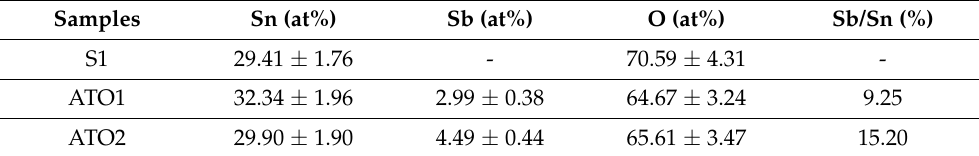
Figure 3. X-ray diffraction patterns ( a ) and crystallinity size ( b – d ) of S1, ATO1, and ATO2 estimated by the Rietveld and Le Bail approach from XRD data analysis, in the three directions of (111), (100), and (001). Table 3. Elemental composition of samples obtained from the EDS